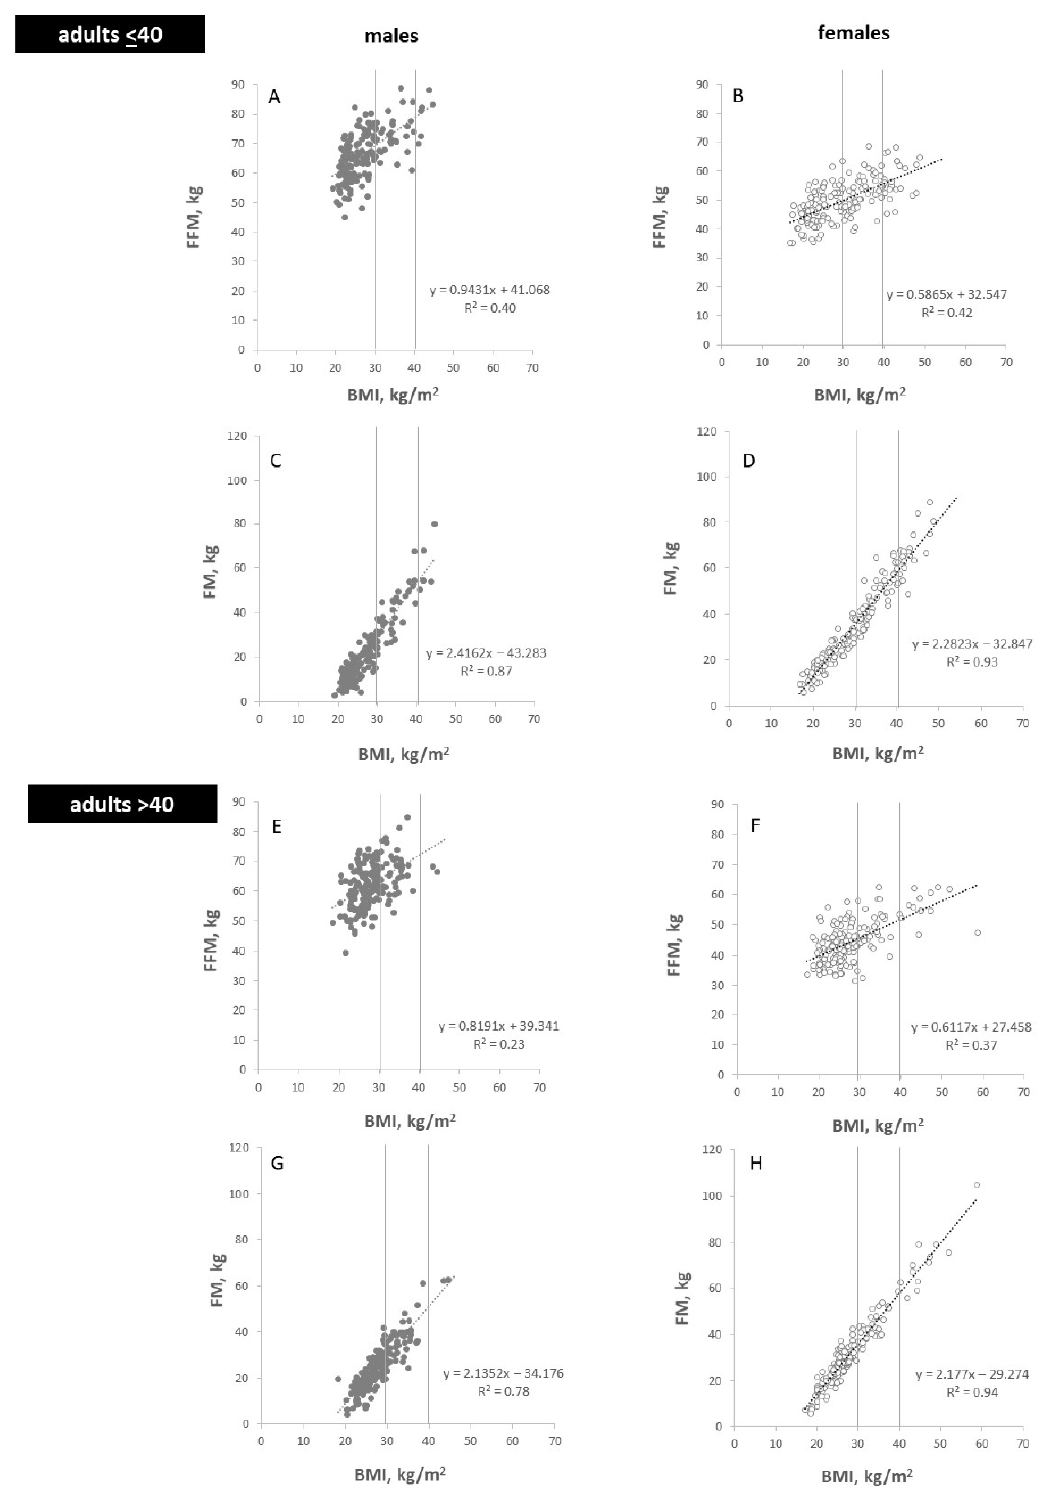
Figure 3. Associations between BMI and either FFM ( A , B , E , F ) and FM ( C , D , G , H ) in males ( A , C , E , G ) and females ( B , D , F , H ) in adults at age < 40 yrs ( A – D ) and >40 yrs ( E – H ). Characteristics of the ‘Kiel study population’: n = 908 subjects; 54% females and 46% males; age range of 18 to 86 yrs with 52% females and 52% males at <40 yrs of age.